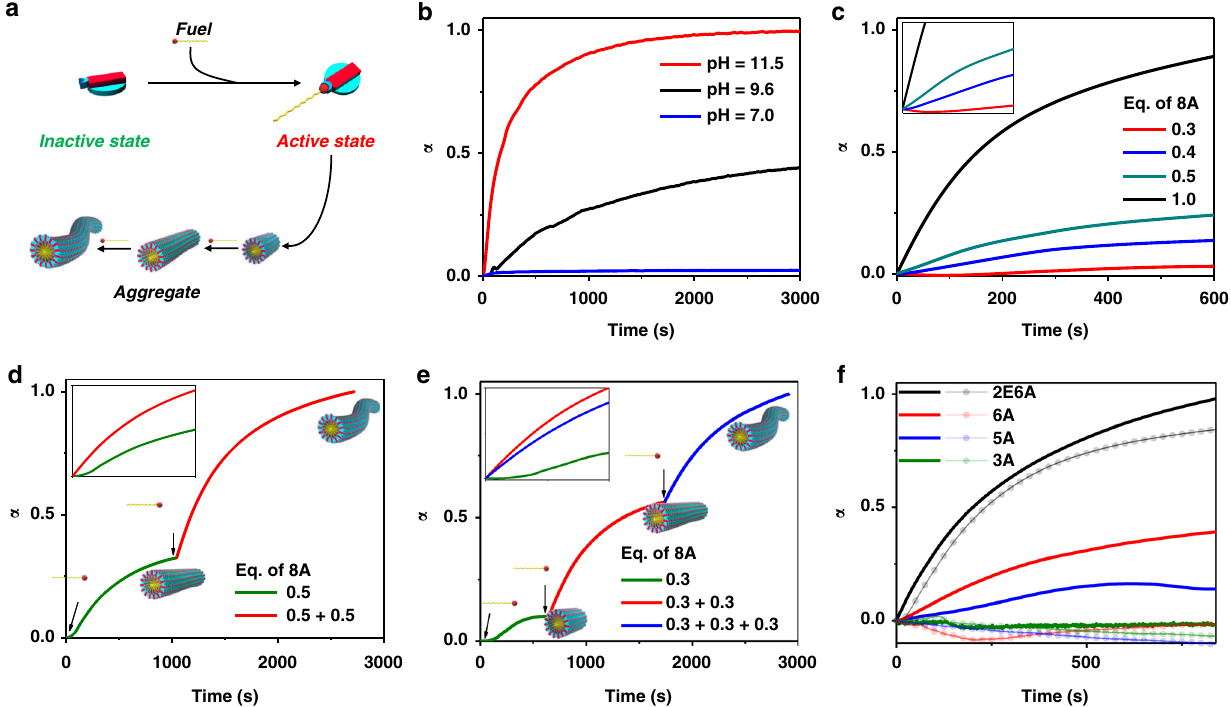
Fig. 2 Characteristics of alkyl amine-driven supramolecular polymerization. a Schematic representation of the extent of self-assembly dependent on the concentration of 8A . Absorption trends at 515 nm of 1.2-8A growth b at various pH, c with various equivalents of 8A , d with 0.5 eq. of 8A added in subsequent batches, e with 0.33 eq. of 8A added in subsequent batches, f with 0.5 eq. of various amines after seeding with 0.5 eq. of 8A . The translucent overlays are pro fi les of unseed growth or respective nAs. (Insets for c , d : respective graphs on linear scale to easily elucidate the change in lag phase and kinetics.) Arrows indicate the addition of respective nA . (For b , c , f : [ 1 ] = [ 2 ] = 1 mM, 50 mM pH = 11.0 buffer; for d , e : [ 1 ] = [ 2 ] = 0.5 mM, 50 mM pH = 11.0